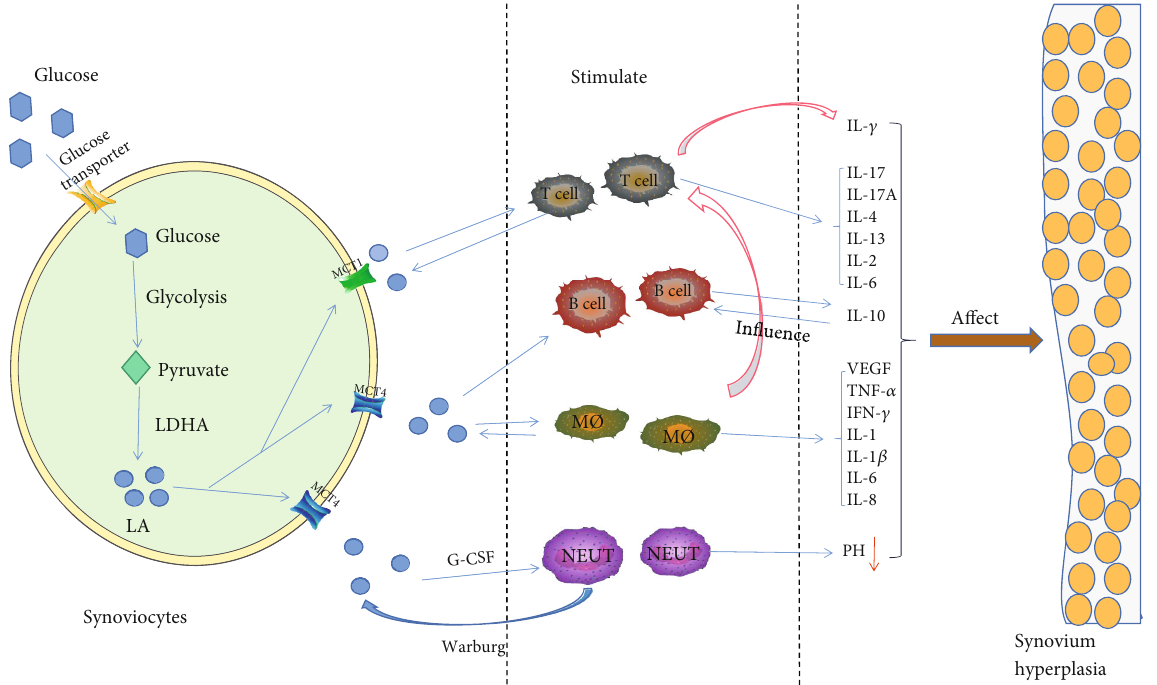
Figure 2: Synoviocytes, T cells, macrophages, and neutrophils in RA in a hypoxic microenvironment. Glycolysis produces a large amount of LA through transporters and accumulates in in fl ammatory tissues to reduce synovial fl uid pH. LA stimulates immune cells to activate, proliferate, and secrete in fl ammatory stimulating factors, which promotes synovial cell proliferation and leads to joint tissue damage and even disability. LDHA: lactate dehydrogenase; MCT1: monocarboxylic acid transporter 1; MCT4: monocarboxylic acid transporter 4; G- CSF: granulocyte colony stimulating factor; MØ: macrophages; NEUT: neutrophils; IL: interleukin; TNF- α : tumor necrosis